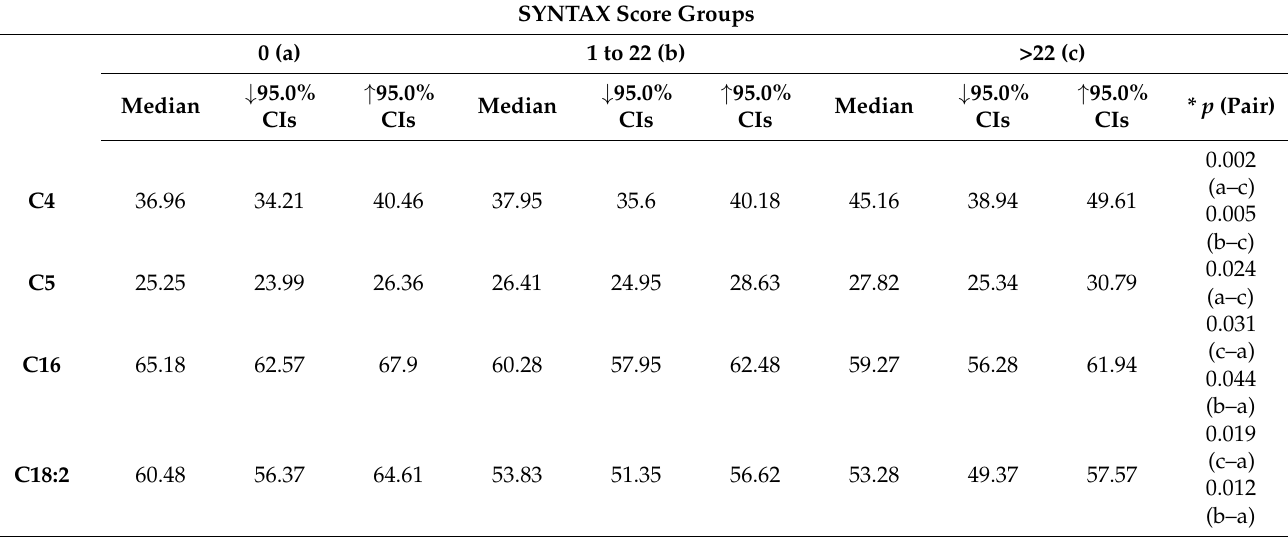
Table 6. Acylcarnitines with significantly different levels ( µ g/L) across SYNTAX Score